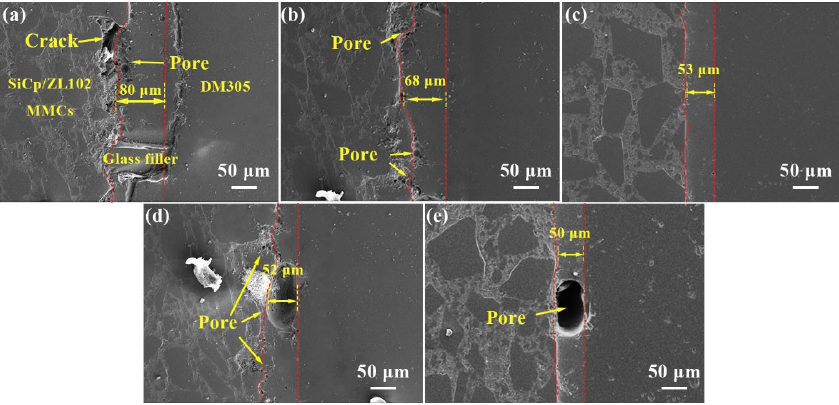
Figure 4. SEM images of the typical sealing joints at different sealing temperatures for 30 min: ( a ) 530, ( b ) 530, ( c ) 540, ( d ) 550, and ( e ) 560 °C.